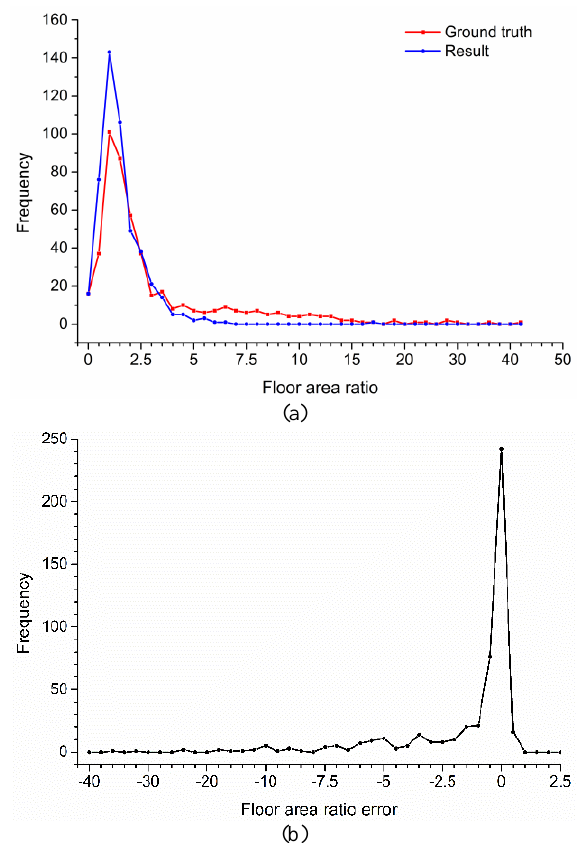
Figure 6. Distributions of block FAR values and errors. (a) Block FAR value distribution comparison between result and ground truth. (b) Block FAR error distribution.